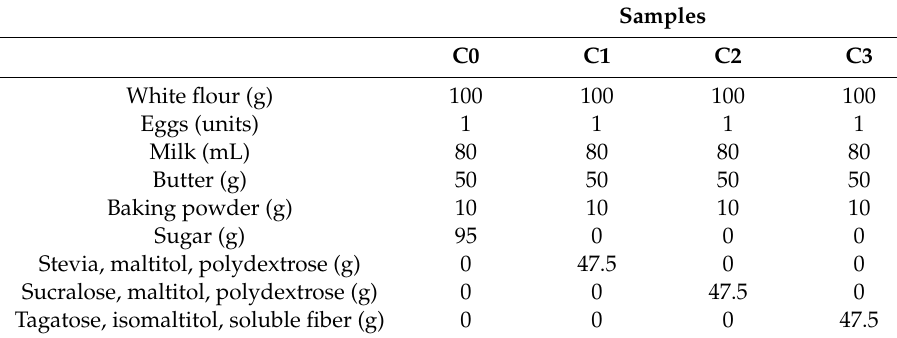
Table 1. Formulations of cupcakes